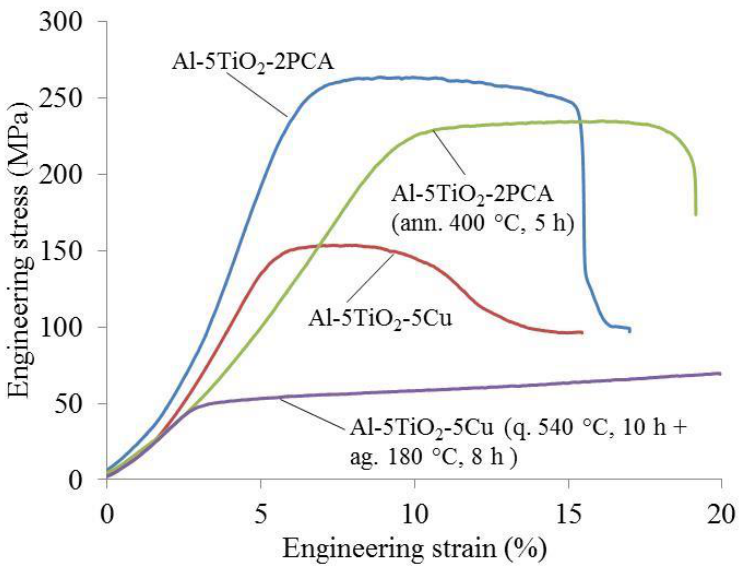
Figure 8. Compression stress-strain curves of the hot-pressed materials in different states at 300 °C.